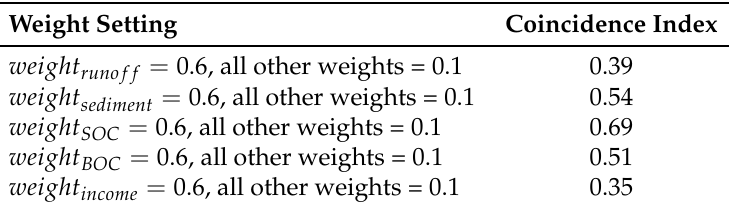
Table 11. Coincidence index values comparing the output of BIOLP for the reference scenario and for scenarios using different weight settings ( λ was set to 0.5).